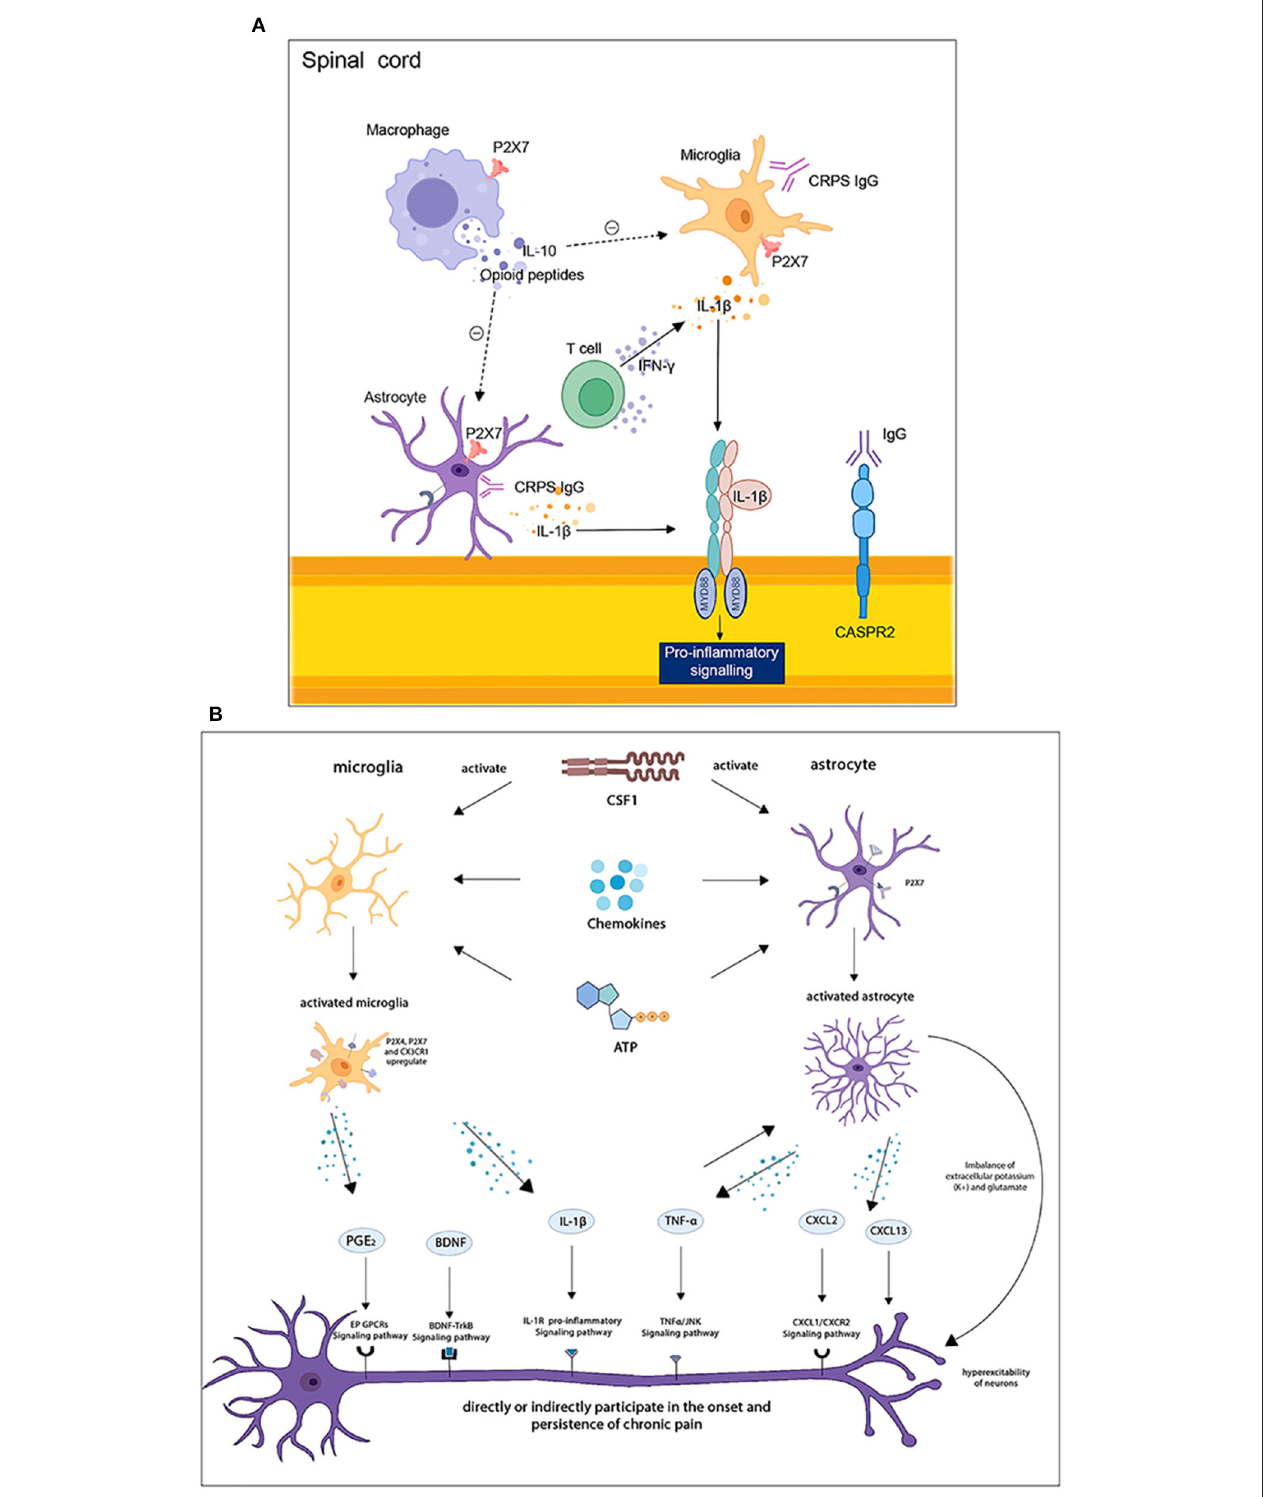
FIGURE 4 | (A) Immune cells interplay in the spinal cord. (B) Central neuron-glial cells interactions in the spinal cord and brain. T cells release IFN- γ to activate astrocytes and induce pain, while macrophages produce substances such as IL-10 that promote pain resolution. Activated astrocytes and microglia secrete IL-1 β , which promotes the release of pro-inflammatory factors. Astrocytes and microglia are activated by CSF1, chemokines, and ATP, and secrete BDNF, IL-1 β , TNF- α , CXCL2, and other neuronal modulators, which are involved in the development and maintenance of chronic pain through corresponding signaling pathways.